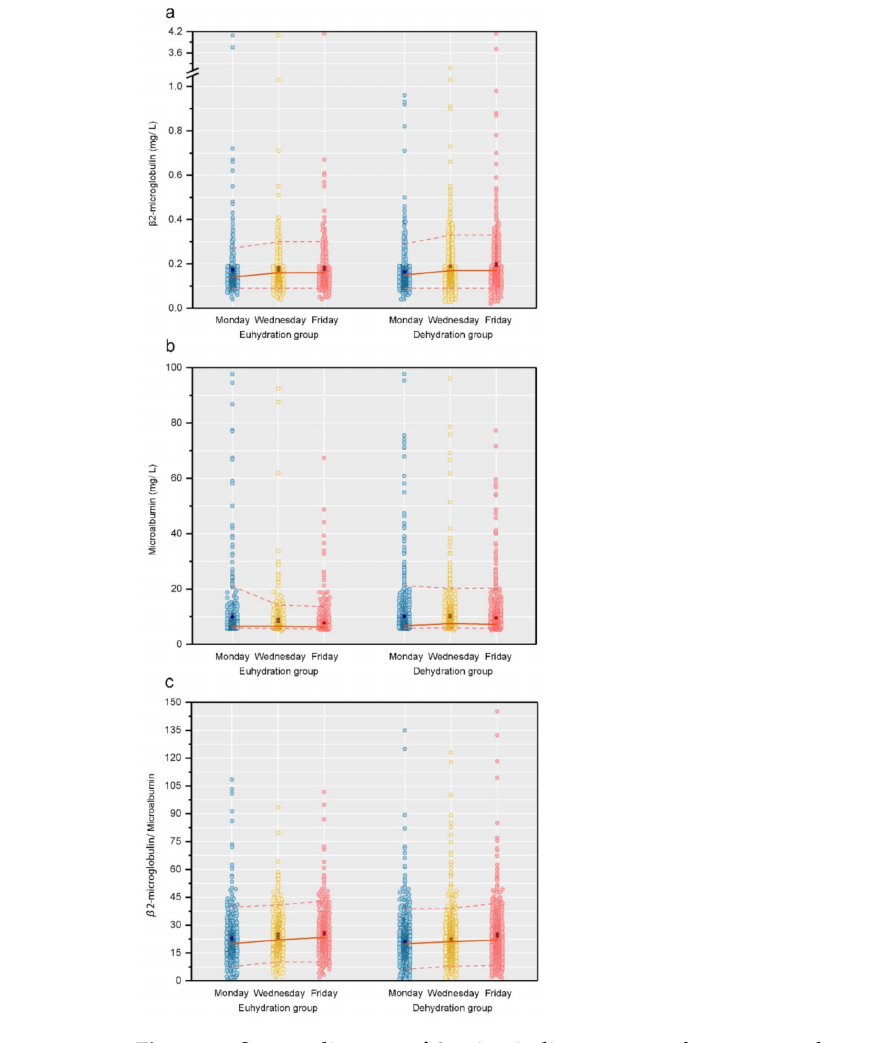
Figure 2. Scatter diagram of 3 urine indicators over three repeated measurements by hydration status groups among school children in Beijing. (Illustrations: ( a ) for β 2 -microglobulin; ( b ) for microalbumin; ( c ) for β 2